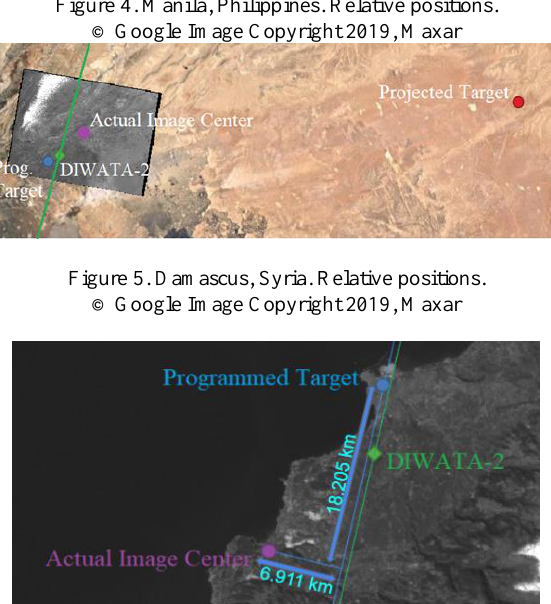
Figure 4. Manila, Philippines. Relative positions.